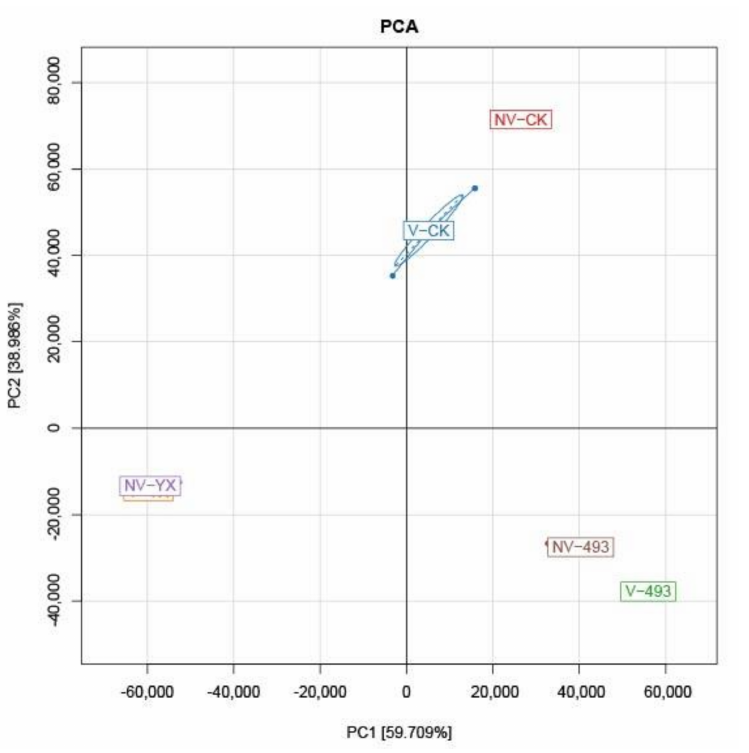
Figure 1. Principal component analysis (PCA) of bacterial communities in alfalfa silage at 90 days. Control, CK; vacuum treatment, V; inoculated with YX, YX; inoculated with Lactobacillus plantarum ZZUA493, 493; nonvacuum treatment,